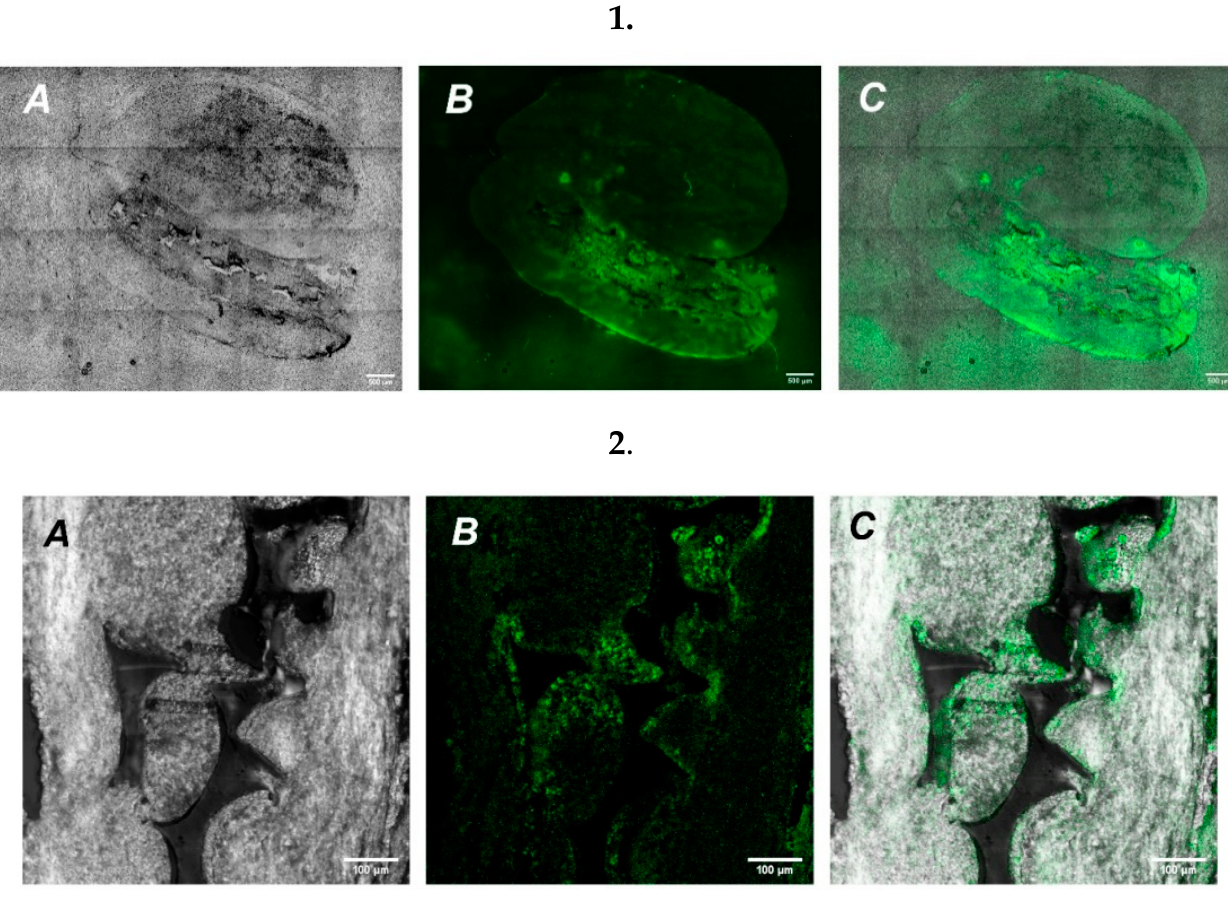
Figure 5. A series of confocal tilescans (Row 1 ) and magnified high resolution images (Row 2 ) of mice brain (frontal cut) at the 7th day after UHMWPE implantation. ( A )—UHMWPE in brain tissue, phase contrast (grey); ( B )—SH-SY5Y cells expressing GFP (green); ( C )—merged. Scale: Row 1—500 µm, Row 2—100 µm.